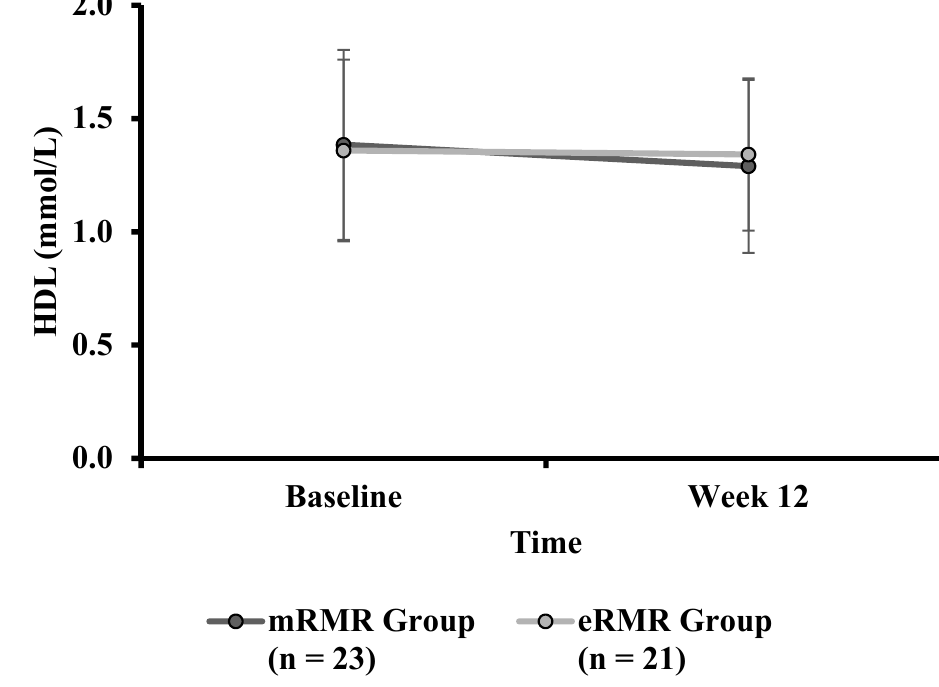
Figure 5. High-density lipoprotein (mmol/L) measured at baseline and week 12 for the mRMR ( n = 23) and eRMR groups ( n = 20). 3.15. Total Cholesterol to High-Density Lipoprotein Ratio